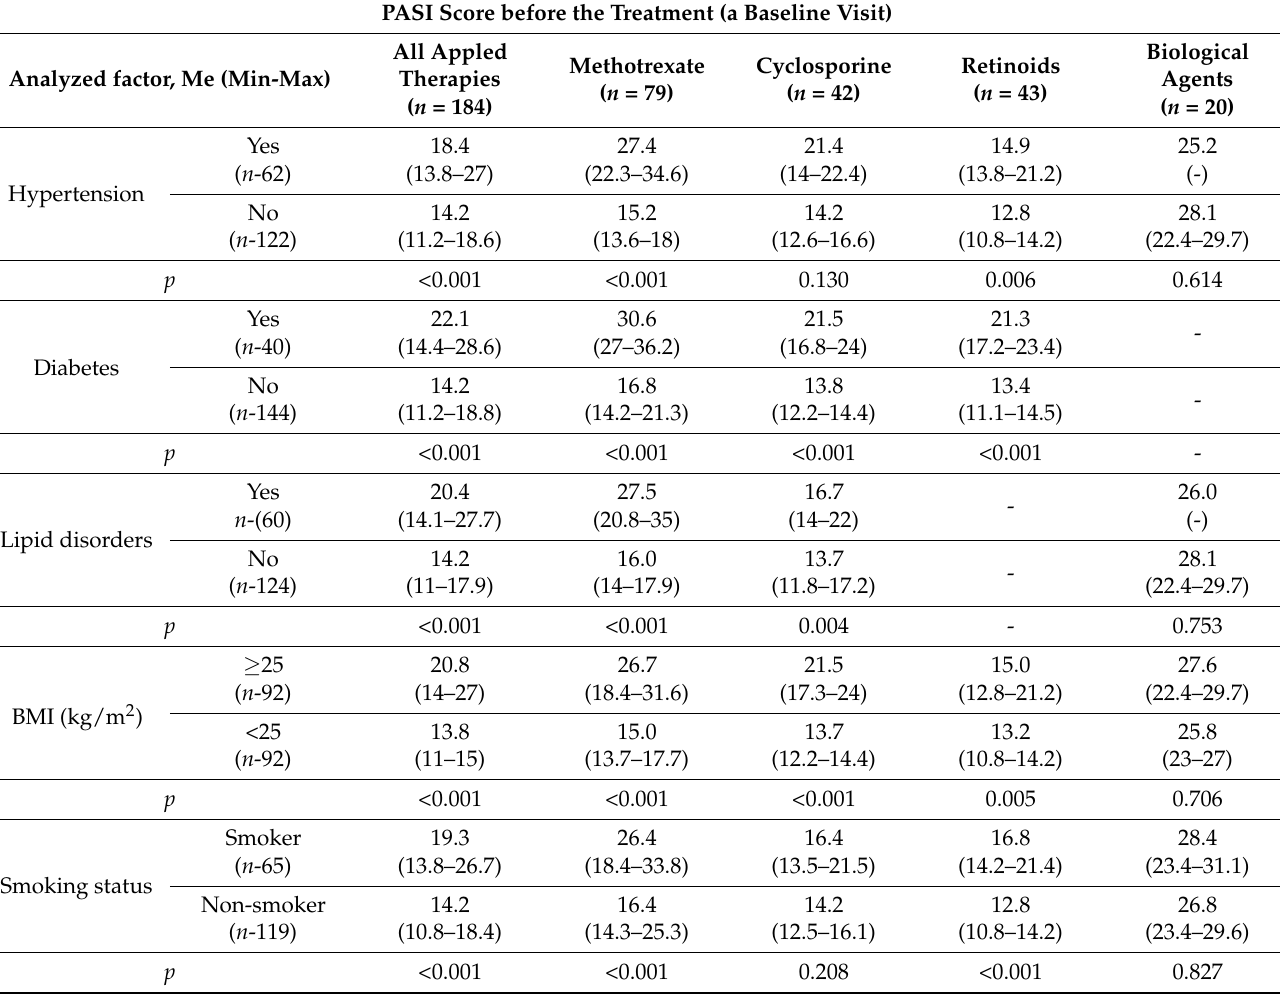
Table 3. The PASI score before the treatment (a baseline visit), after a 3-month therapy (a control visit) as well as PASI reduction in psoriasis patients treated with different therapies depending on the presence of comorbidities, BMI score and smoking status. PASI Score before the Treatment (a Baseline Visit) Analyzed factor, Me